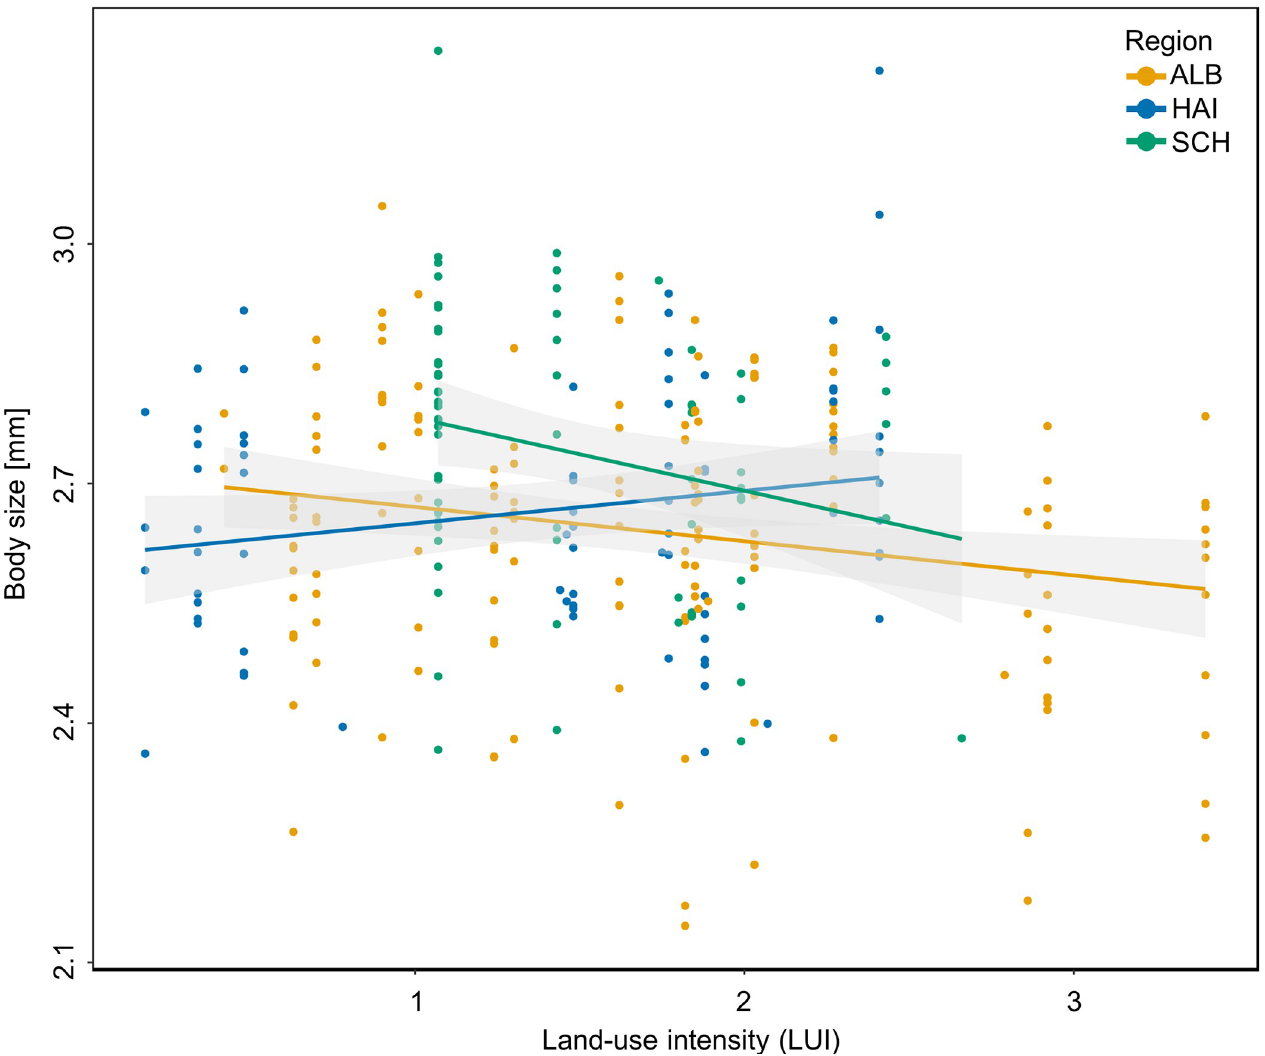
Fig 5. Effects of land-use intensity index LUI and of region on body size of B . lapidarius workers. The decreasing body size of workers can be explained by an interaction of LUI and region (LMM: χ 2 = 6.682, N = 307, p < 0.05). Regression lines for each region, namely Schwa¨bische Alb (ALB), Hainich-Du¨n (HAI), and Schorfheide-Chorin (SCH), and 95% confidence intervals are